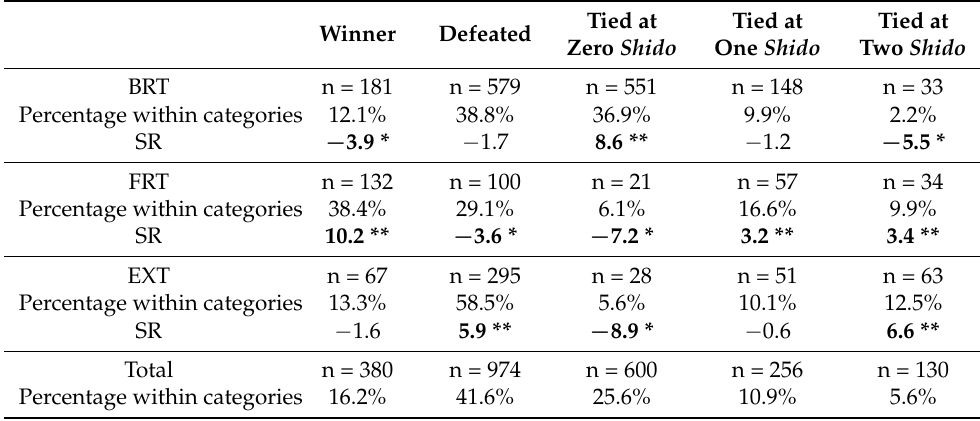
Table 5. Relation between when a contest ended (WhCE: contests ending before the accomplishment of the regular time of 4 m (BRT), finishing at the regular time of 4 min (FRT) and finishing during the golden score period (EXT)) and the distribution of shido (n =